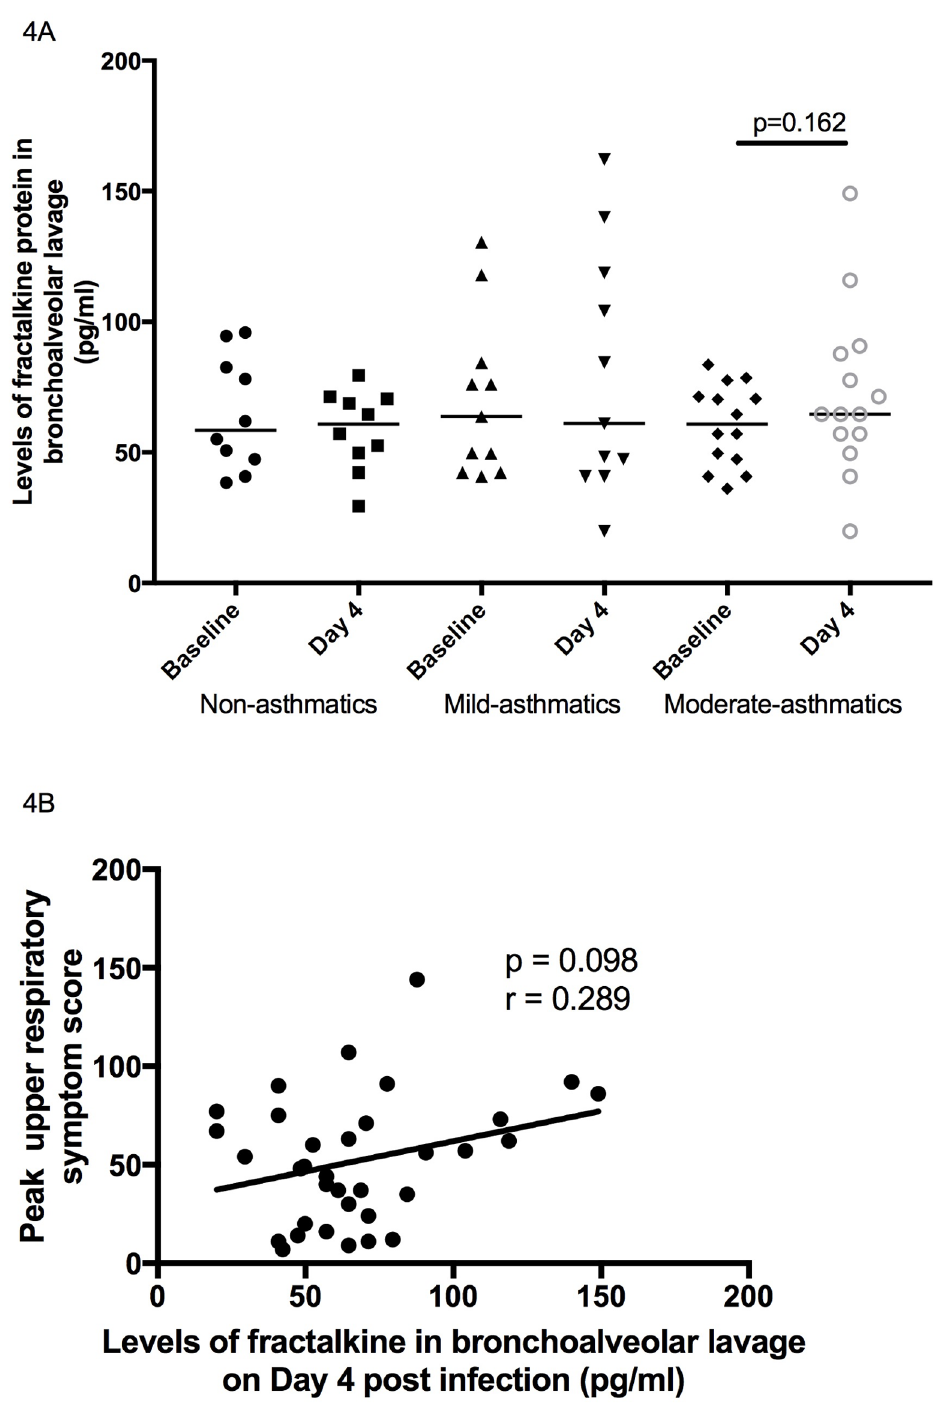
Fig 4. Change in soluble fractalkine in BAL fluid during experimental in vivo RV16 infection, related with upper respiratory symptom scores. Solublefractalkineprotein was measuredin filtered BAL fluid collectedat baselineand day 4 post RV16 infectionfrom non-asthmatic (n = 10), mild-asthmatic (n = 11) and moderate-asthmatic (n = 14) subjects. (A) Data is presentedas solublefractalkine(pg/mL) per subject and horizontal bars for median levels for each group in BAL fluid obtained at baselineand day 4. Data were analysedwithin groups by Wilcoxon-matchedpairs signed rank tests and betweengroupsby Mann Whitney U test, * P < 0.05.(B) Levels of fractalkinein BAL fluid on Day 4 were correlatedwith peak upper respiratory symptom scores for each subject infected using Pearson’scorrelation(r = 0.289, P = 0.098).